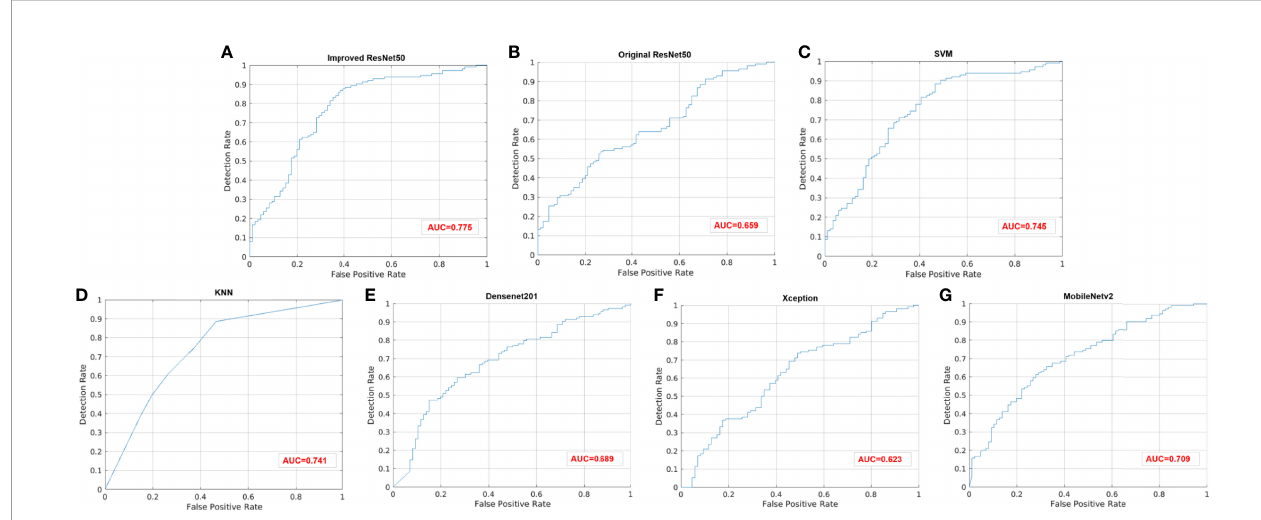
FIGURE 4 | ROC curves of different models. (A) Improved ResNet50. (B) Original ResNet50. (C) SVM. (D) KNN. (E) DenseNet201. (F) Xception. (G) MobileNetv2.